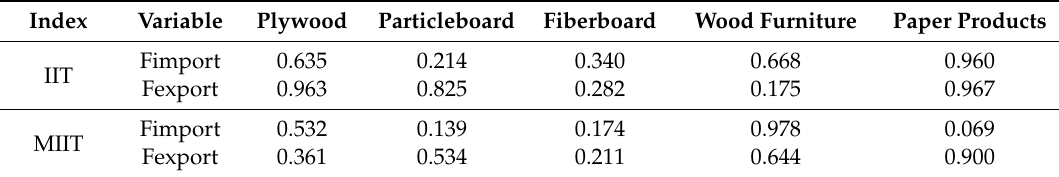
Table 8. Endogenous test